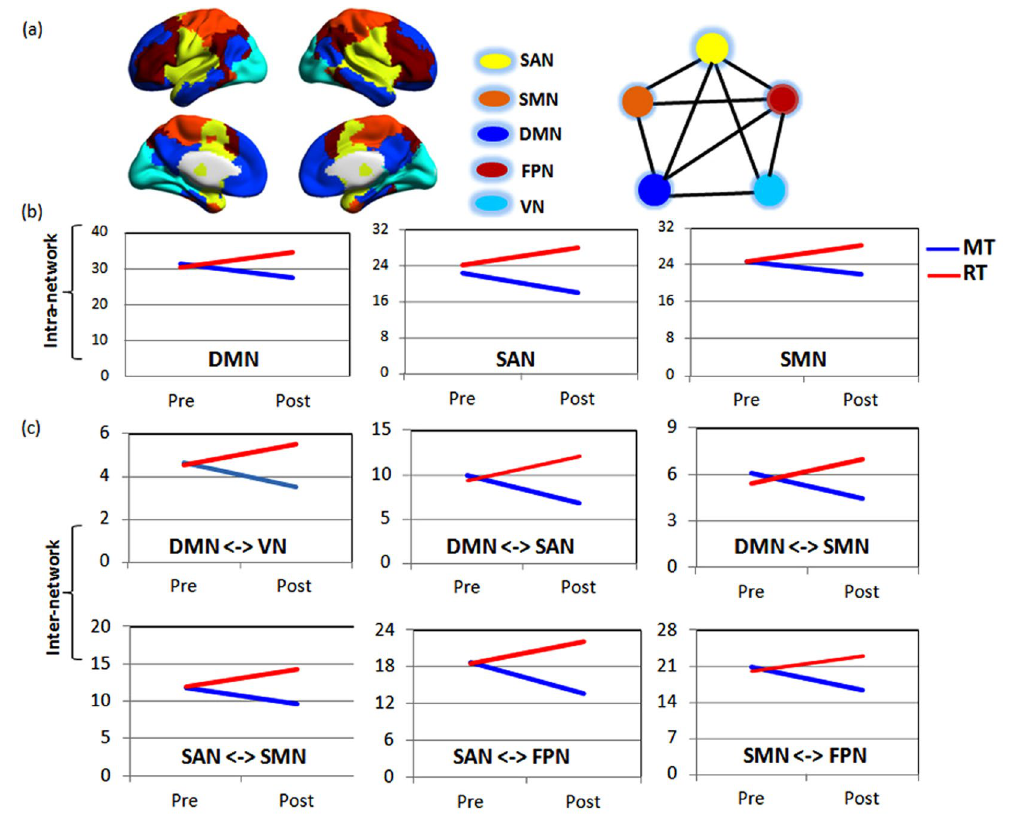
Figure 2. The Effects of training on intermediate modular structure. Five modules were identified for the group-level mean network of pre-test phrase ( a ) including the default mode network (DMN), salience network (SAN), somotomotor network (SMN), fronto-pariteal network (FPN), and visual network (VN). Further statistical analysis revealed significant interactions between timing and group ( p < 0.05, corrected) on the intra- module and inter-module functional connectivity. Figures ( b and c ) show the post test for the intra-module/ inter-module functional connectivity showing interaction. The results represented on the brain surface were mapped using the BrainNet viewer 52